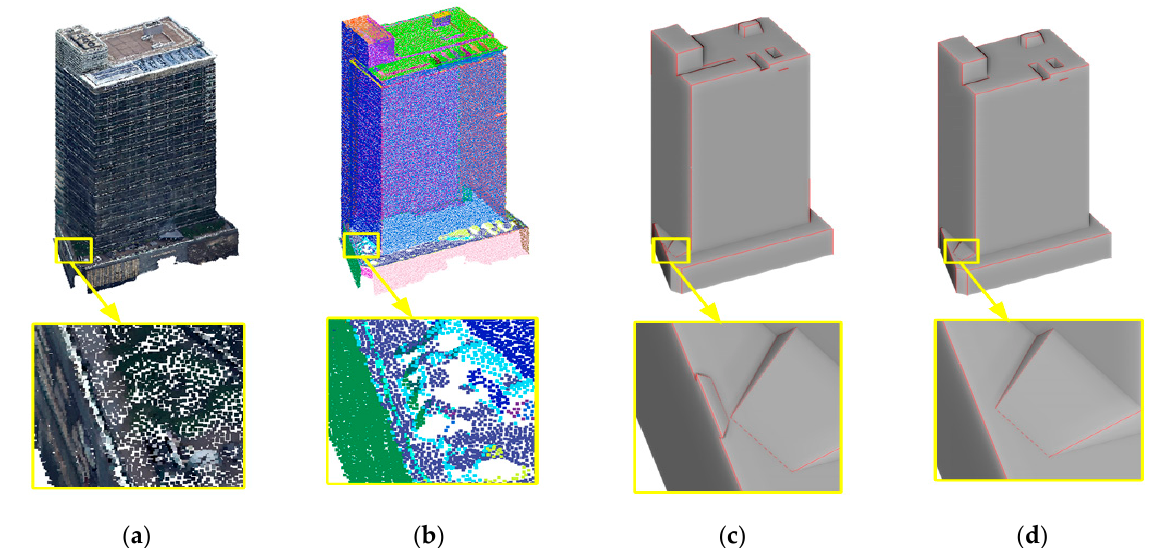
Figure 9. Geometric models of a building formed by occupied cells selected with and without edge regularity constraints. ( a ) Original building point cloud; ( b ) Planar primitives in colored points; ( c ) Optimal selection result without edge regularity constraint ( γ = 1, η = 0); ( d ) Optimal selection result with edge regularity constraint ( γ = 1, η = 5).